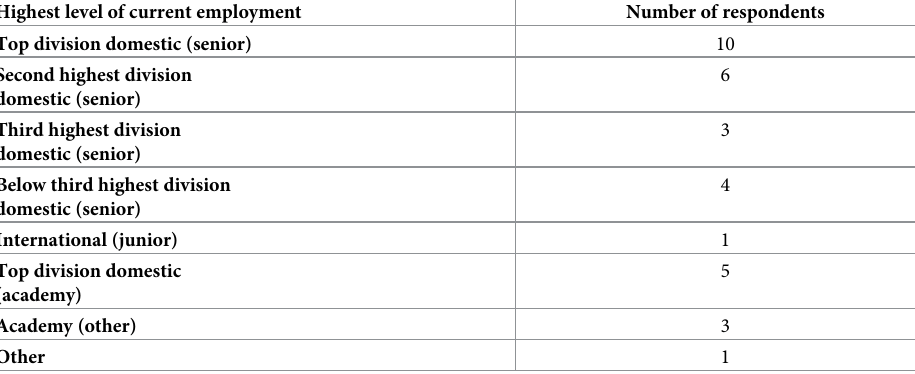
Table 1. Highest level of professional soccer at which respondents were employed at the time of survey comple- tion (N = 33). Highest level of current employment Number of